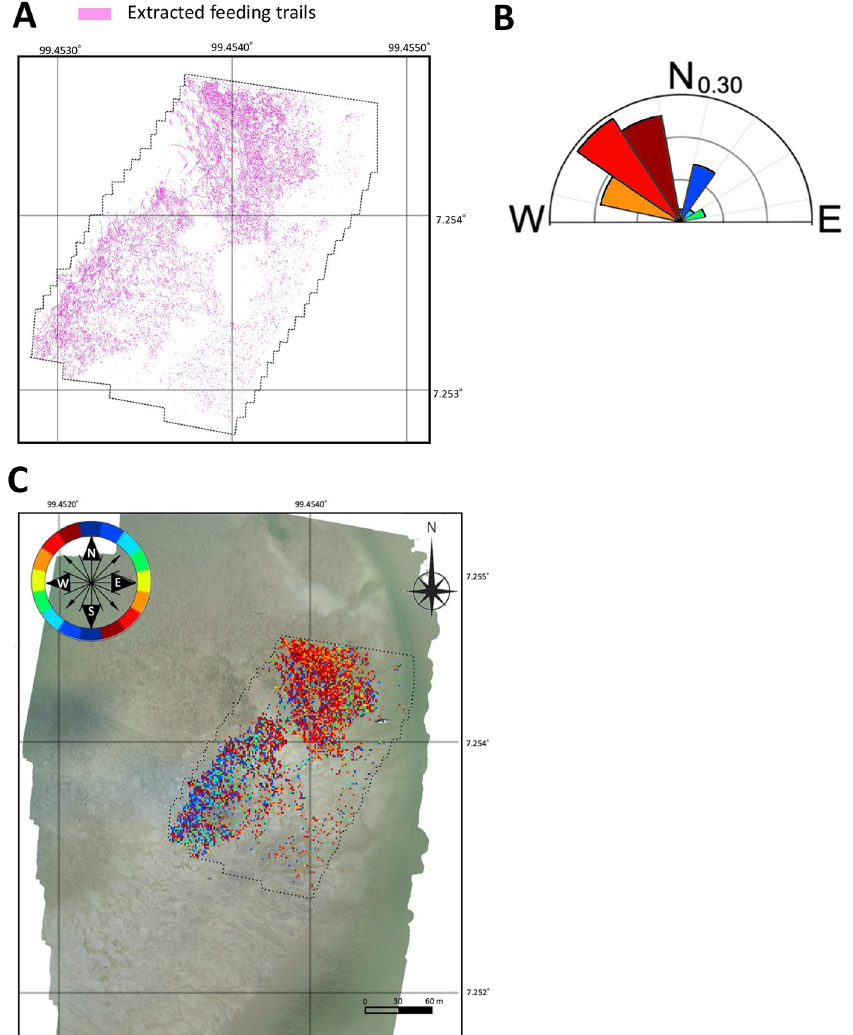
Fig 15. Example of the (A) input and (B) (C) output from the estimation algorithm for the feeding trails’ direction. The pink lines in (A) show feeding trails extracted by the Model_1. (B) shows the circular histogram of the estimated direction. In (C), each block of 256 × 256 pixels within the aerial observation area (dotted line) was classified into 8 colors according to the estimated direction (0˚, 22.5˚, 45˚, 67.5˚, 90˚, 112.5˚, 135˚, and 157.5˚, and the corresponding legend is in the upper left of the feeding